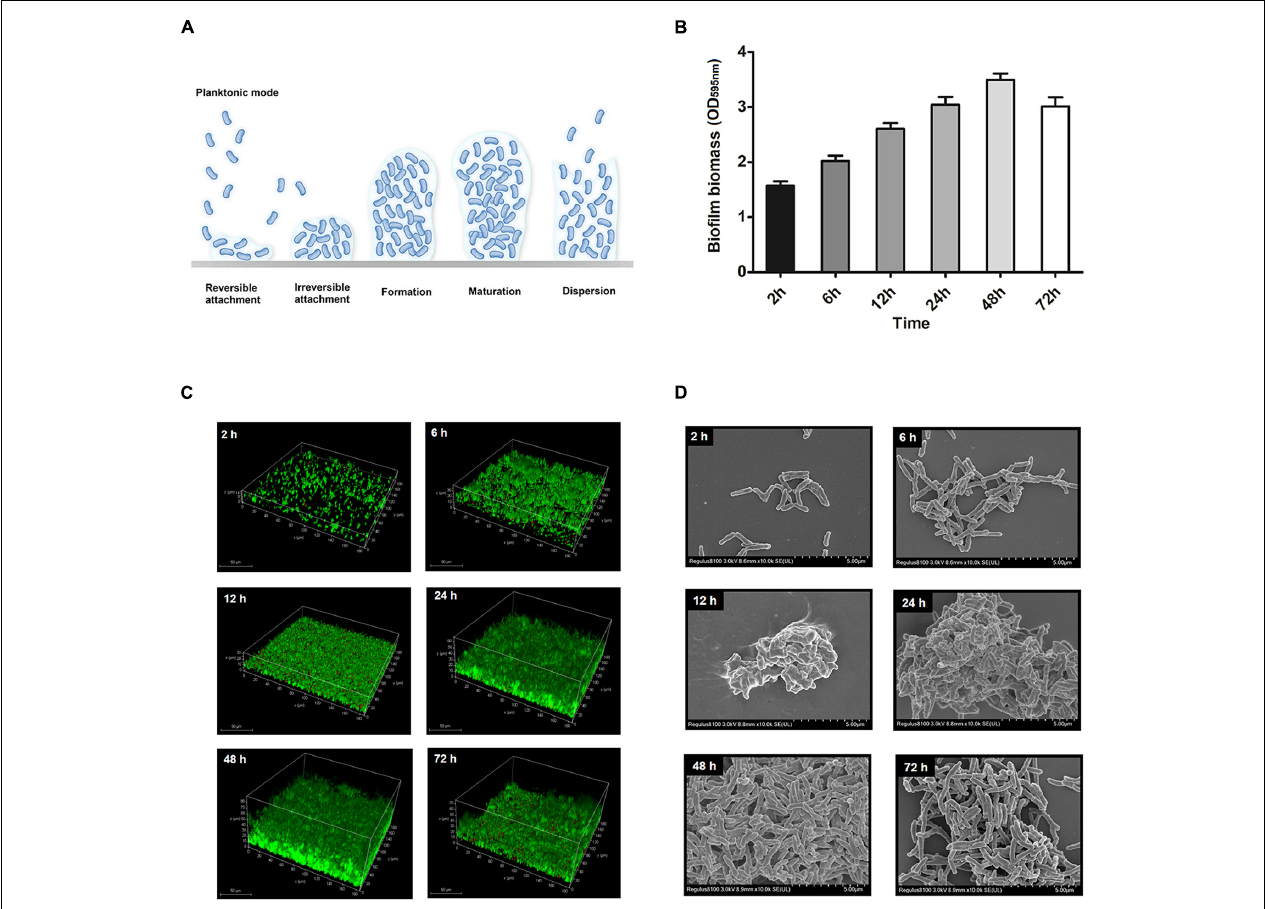
FIGURE 4 | Model for static T. pyogenes biofilm development. (A) With respect to biofilm development, the 6 steps were planktonic stage, reversible attachment, irreversible attachment, biofilm formation, biofilm maturation and dispersion. (B) Biofilm biomass at different time points stained with CV. (C) BMH06-3 biofilms were grown on cell culture dishes stained with Syto9 (green) and propidium iodide (red). The volume projection of a Z-stack is shown. (D) Scanning electron micrographs of BMH06-3 biofilms at × 10,000